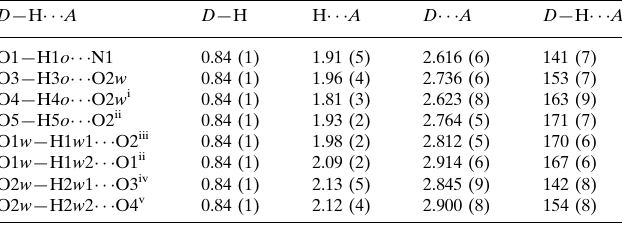
Hydrogen-bond geometry (A˚ , (cid:2)